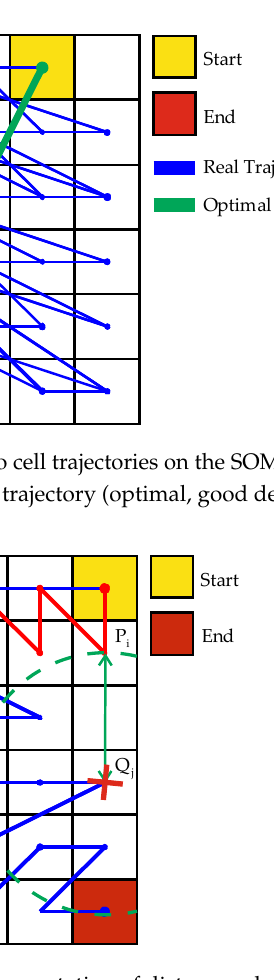
Figure 9. Representation of distance calculation in the Separability Index ( SI ).